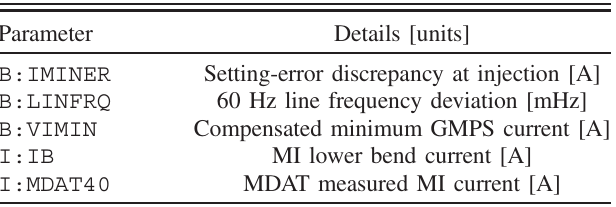
TABLE I. Description of dataset parameters chosen by experts and later validated with a causality study. Here, “ MI ” means Main Injector, “ MDAT ” means accelerator (machine) data communi- cation, and device parameters that begin with B are related to the Booster, whereas device parameters that begin with I are related to the Main Injector.